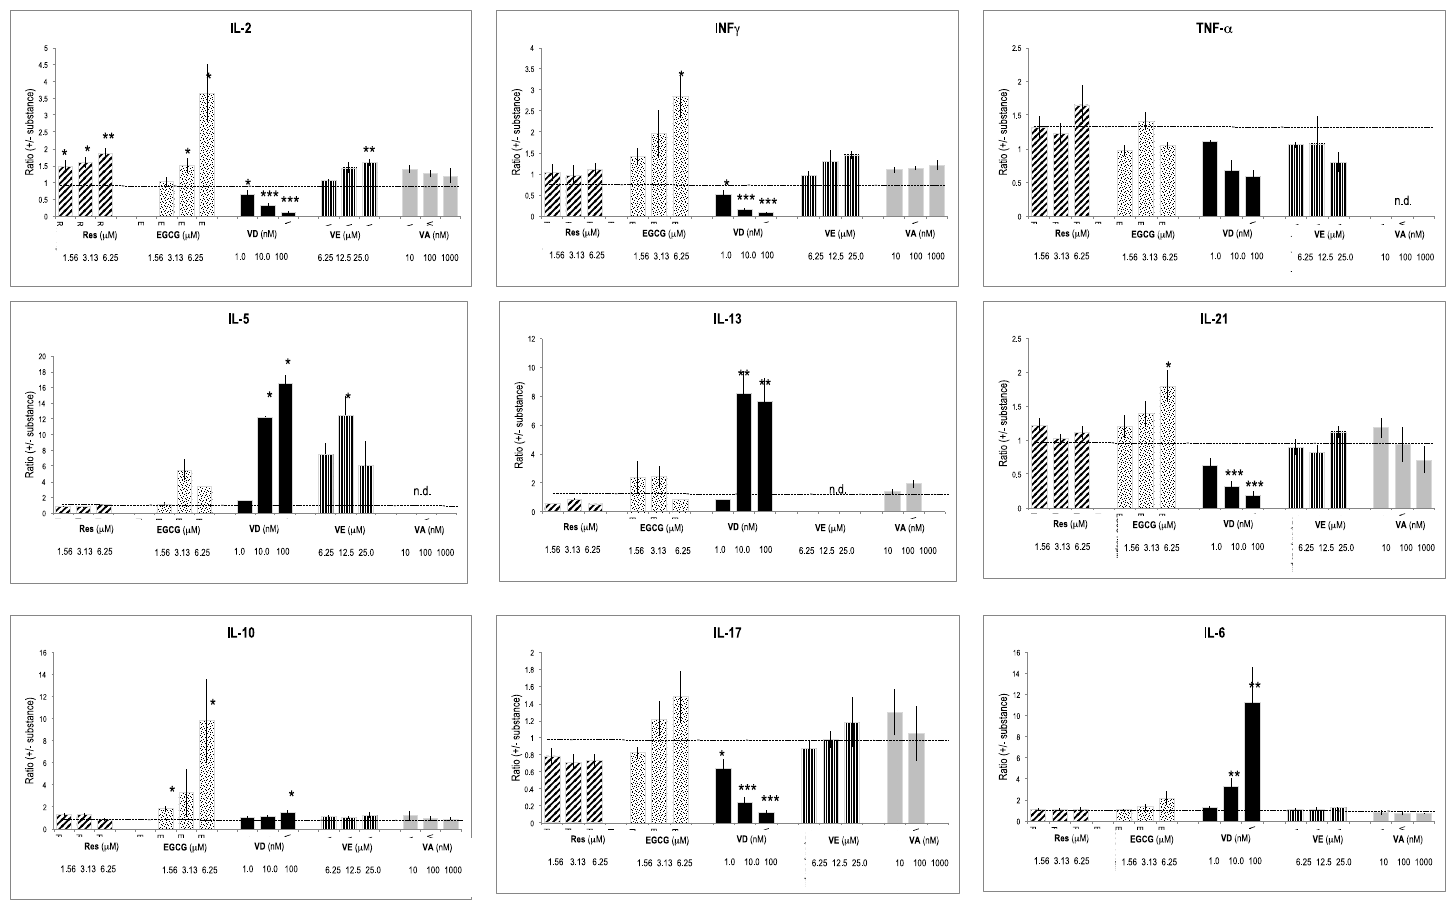
Figure 4. Effect of substances on gene expression. PBMCs were cultured for 4 days (see: reference added in proof), and the gene expression was quantified by real-time PCR. Fold-changes (versus un-activated cells) were determined (see [30,31]). The effect of substances was computed as a ratio (fold-changes in the presence of substances/fold-change with vehicle only). Bars indicate SD (N = 4). * = p < 0.05; ** = p < 0.01; *** = p < 0.001. The dotted line in the graphs indicates the level of the reference ratio (=1).